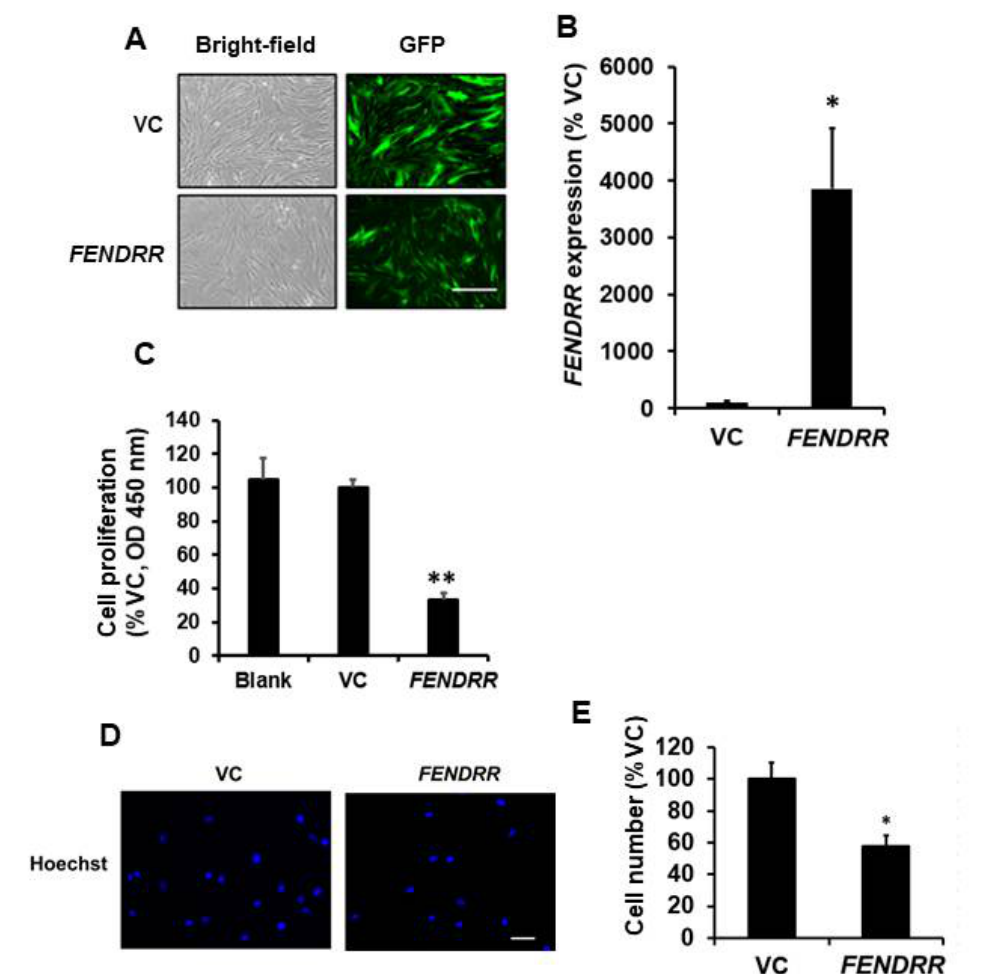
Figure 1. FENDRR has a negative effect on lung fibroblast proliferation. ( A ) Bright-field and GFP images of LL29 stable cells expressing GFP- FENDRR (FENDRR) and GFP vector control (VC). Scale bar: 100 µm. ( B ) Real-time PCR determination of FENDRR expression levels in the stable cells. FENDRR expression was normalized to β-actin and expressed as %VC. ( C ) Cell proliferation was determined by the BrdU assay in blank cells, VC, and FENDRR expressing stable cells after 6 days of culture. The results were expressed as %VC. ( D ) Nuclei staining of VC and FENDRR stable cells after 6 days of culture. Scale bar: 100 µm. ( E ) Cell counts of VC and FENDRR stable cells. In each experiment, 5 random fields were imaged, numbers of nuclei were counted, and cell counts were averaged. Cell counts were expressed as %VC. The cell counts for VC and FENDRR were 19.7 ± 2.0 and 11.3 ± 0.8 per field. Values represent the means ± SE. n = 3 independent experiments. * p < 0.05, ** p < 0.01 vs. VC. Student’s t-test for ( B, E ) and one-way ANOVA and Tukey’s multiple comparison for ( C ).